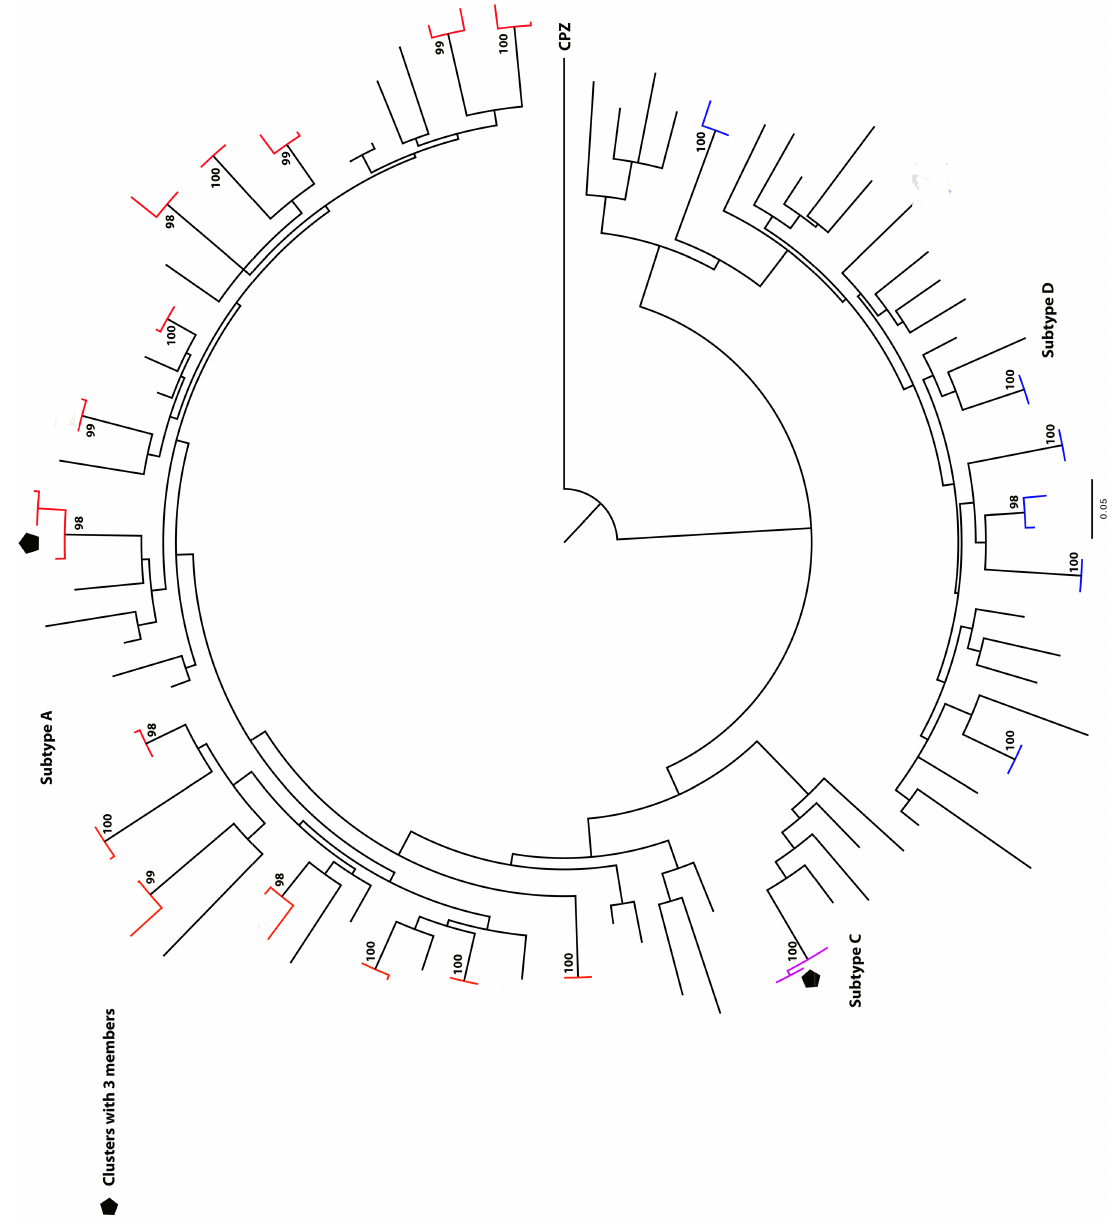
Fig 3. Maximum-likelihood phylogenetic tree showing the HIV transmission clusters in gag gene approximately 463 base pairs (n = 25) involving 86 of the 276 participant sequences. Clusters with bootstrap support (cid:21) 95% and genetic distanceof (cid:20) 3.5% are shown. Three clusters with > 2 members are shown whilethe rest of clusters had two members. Subtype A clusters are highlighted red and subtype D blue. The tree scale is shown. cell count above 350 cells/mm 3 (1 unknown) and 7/16 incident cases were early infections < 6 months. The potential recent transmission clusters included 3 couples within the household (male, female), 7 clusters within village (3 male/female, 1 unique pair of females, 1 for males, 2 clusters with n = 3, male/female/female) and 1 pair of male/female cross village/community. Clusters with potential recent transmission were more likely to be younger 71% (15/21) vs 46% (21/46) and newly resident in the area 67% (14/21) vs 48% (22/46).